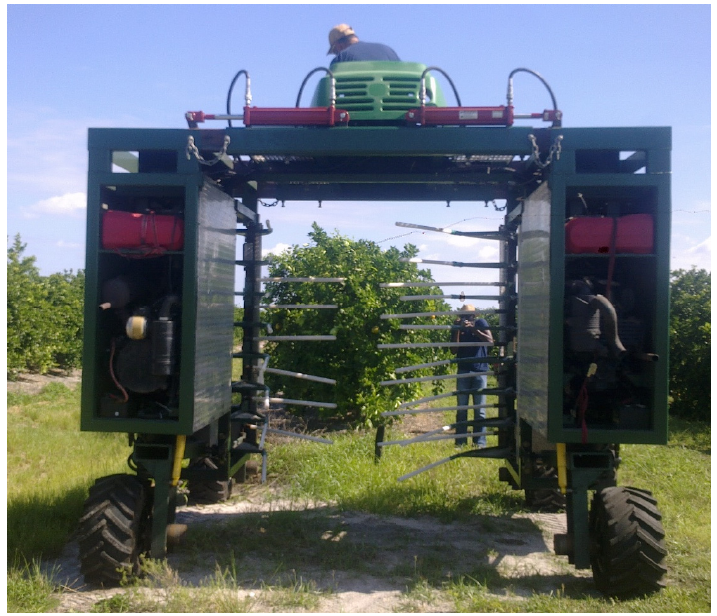
Figure 1. A photograph is showing the customized harvester used in the mechanical harvesting method during 2015 and 2016. method during 2015 and 2016.